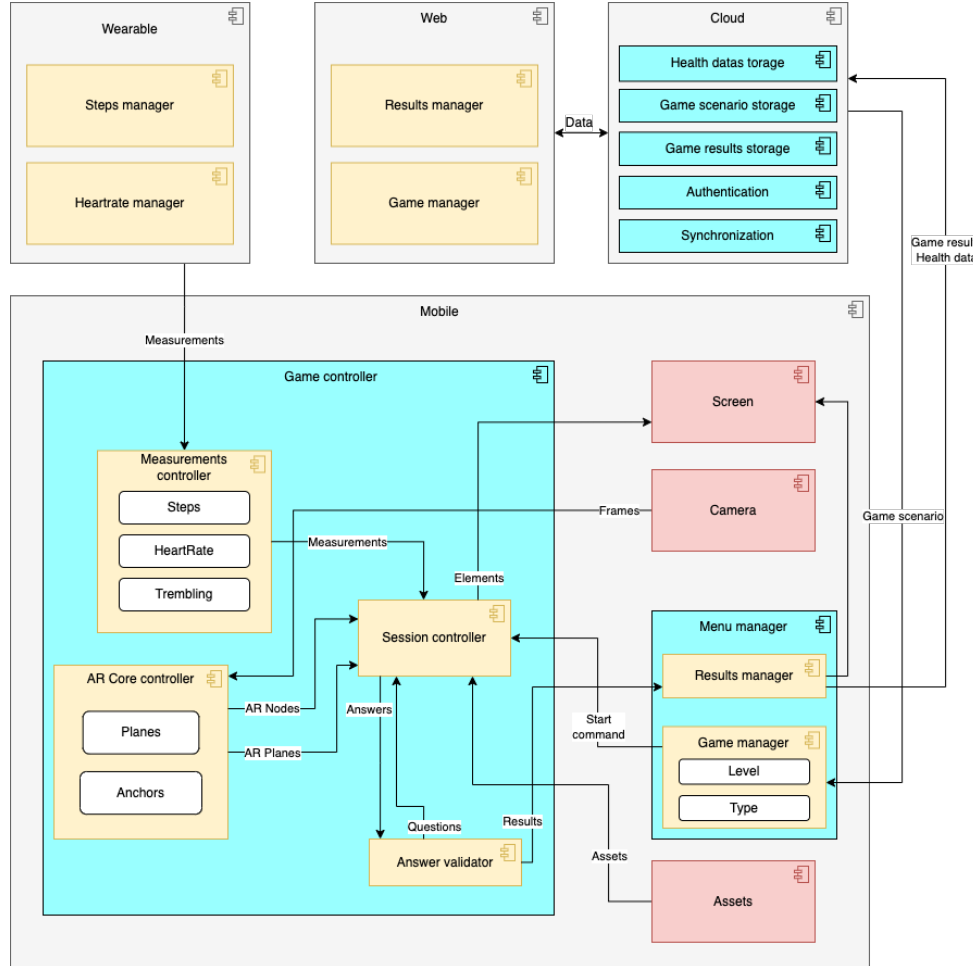
Figure 2. The components of the AR game development